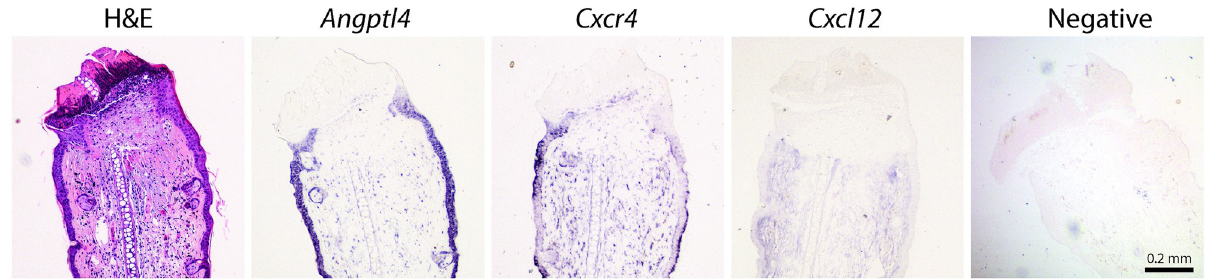
Fig 3. Histology of ear wound at day 2. High power images of H&E, and RNA staining for Angptl4 , Cxcr4 , and Cxcl12 at day 2. Images are representative of n = 3.